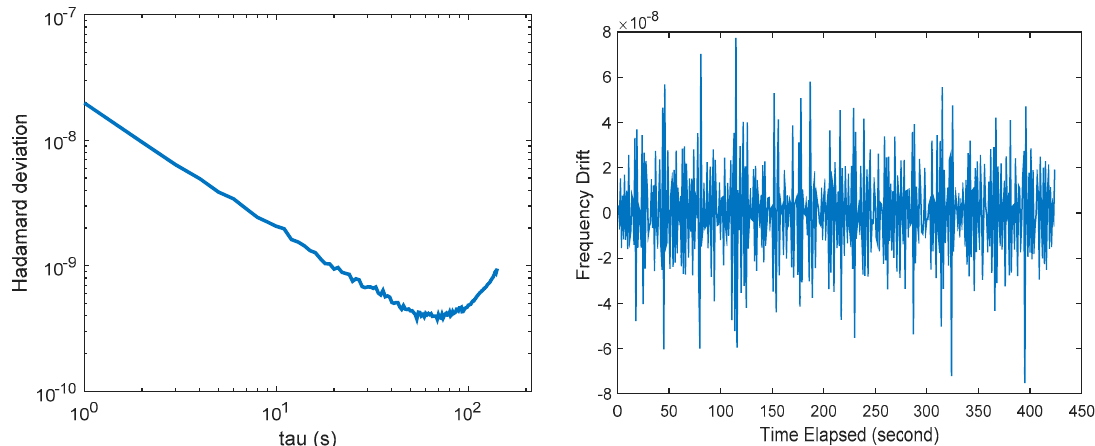
Figure 7. Hardamard variance of the satellite clock ( left panel ) and the frequency drift of the satellite clock ( right panel ).